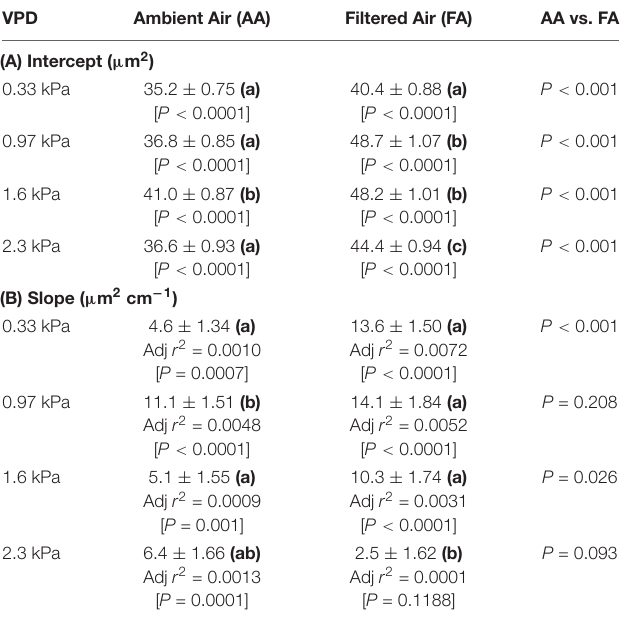
TABLE 2 | Linear regression coefficients of the relationships between the difference in pore area ( (cid:49) A) and the distance between the pores (d). VPD Ambient Air (AA) Filtered Air (FA) AA vs. FA